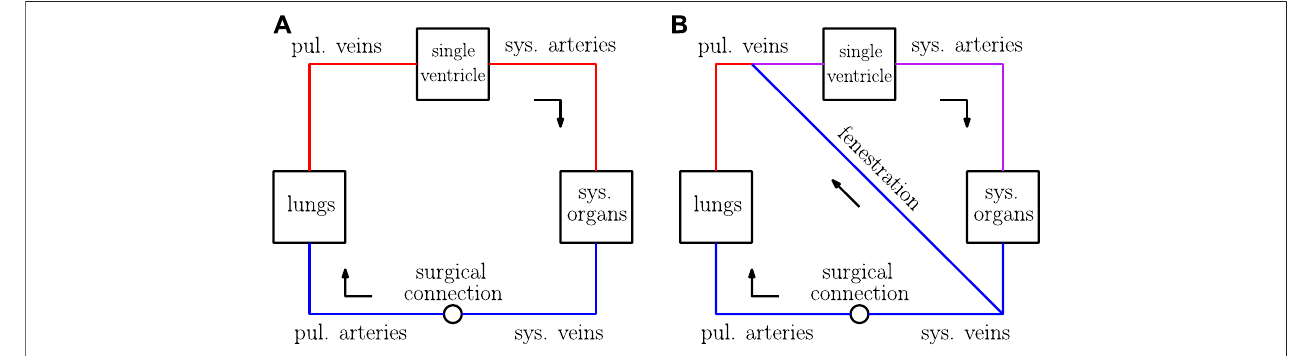
FIGURE1| SketchesoftheFontancirculationinpanel (A) andthefenestratedFontancirculationinpanel (B) .Bluerepresentsdeoxygenatedblood,redrepresents oxygenated blood, and purple represents a mixture of oxygenated and deoxygenated blood.